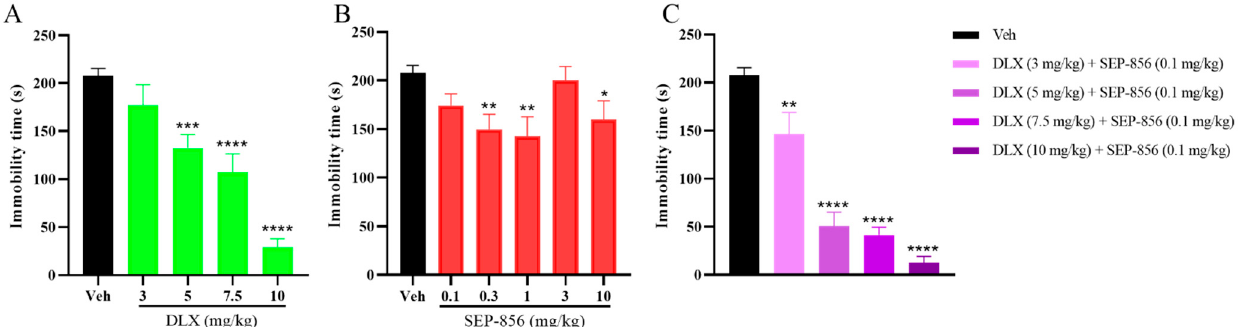
Figure 1. Effects of duloxetine, SEP-856, and their co-administration on the FST in ICR mice. ( A ) Effects of duloxetine (3, 5, 7.5, and 10 mg/kg, p.o.) on behavioral despair in the FST 60 min after administration. ( B ) Effects of SEP-856 (0.1, 0.3, 1, 3, and 10 mg/kg, p.o.) on behavioral despair in the FST 60 min after administration. ( C ) Effects of co-administration of duloxetine (3, 5, 7.5, and 10 mg/kg, p.o.) and SEP-856 (0.1 mg/kg, p.o.) on behavioral despair in the FST 60 after administration. Values are expressed as the mean ± SEM. from 4–8 mice and were analyzed using two-way ANOVA followed by Bonferroni’s post hoc test. * p < 0.05, ** p < 0.01, *** p < 0.001, and **** p < 0.0001 vs. vehicle. DLX, duloxetine.